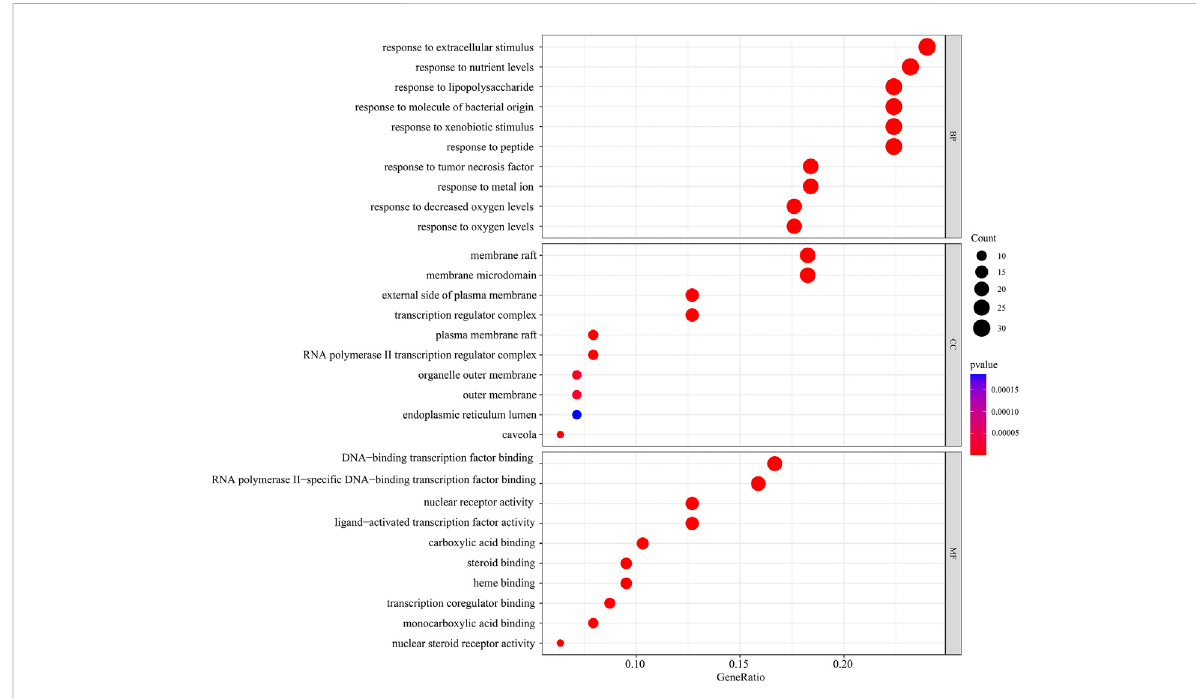
FIGURE 4 The top 10 pathways for the GO function enrichment analysis based on the common targets of LTD and DKD.